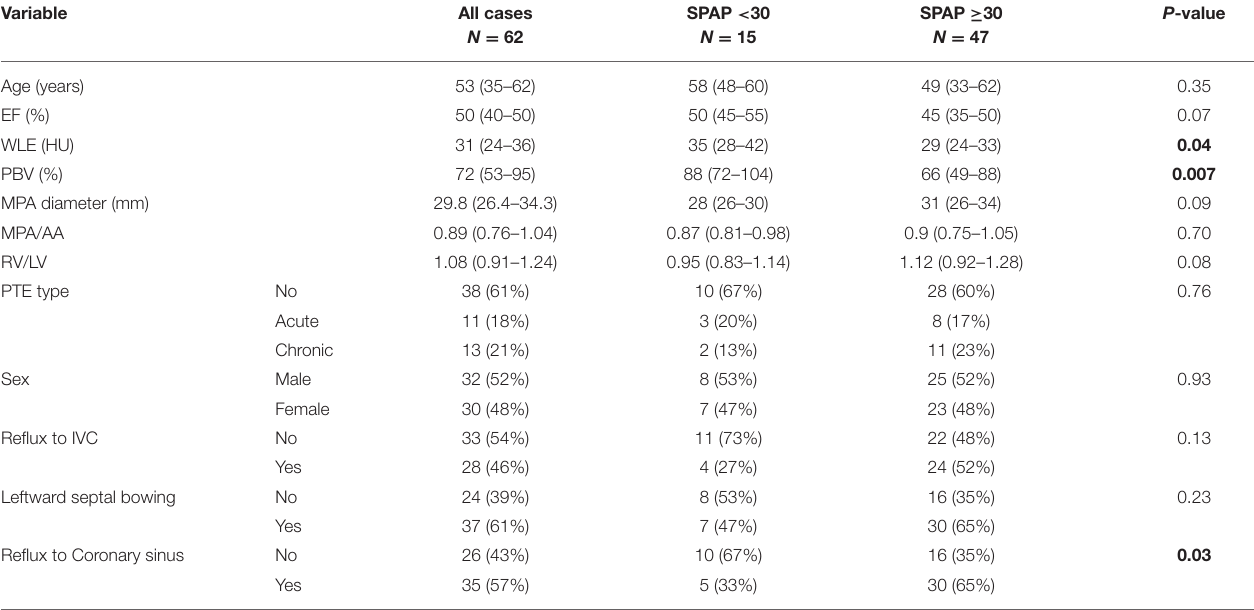
TABLE 2 | Comparison of baseline and CT parameters according to SPAP of more or < 30mm Hg.